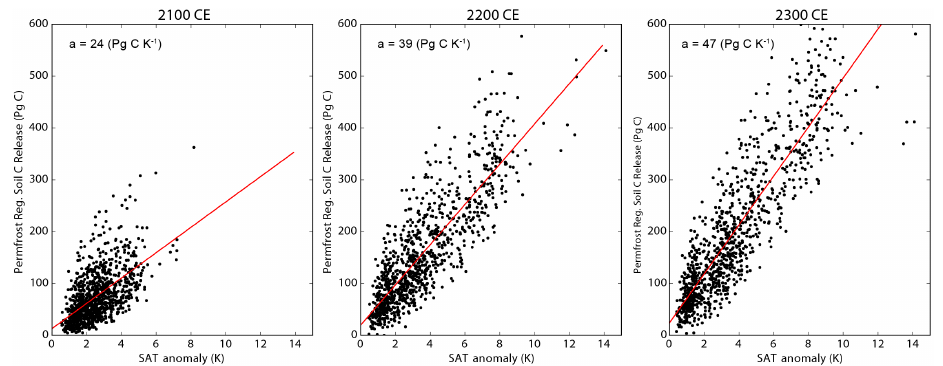
Figure 7. Correlation between release of carbon from the permafrost region and change in global temperature at years 2100, 2200, and 2300CE. Red line is line of best fit and a is the slope of this line.